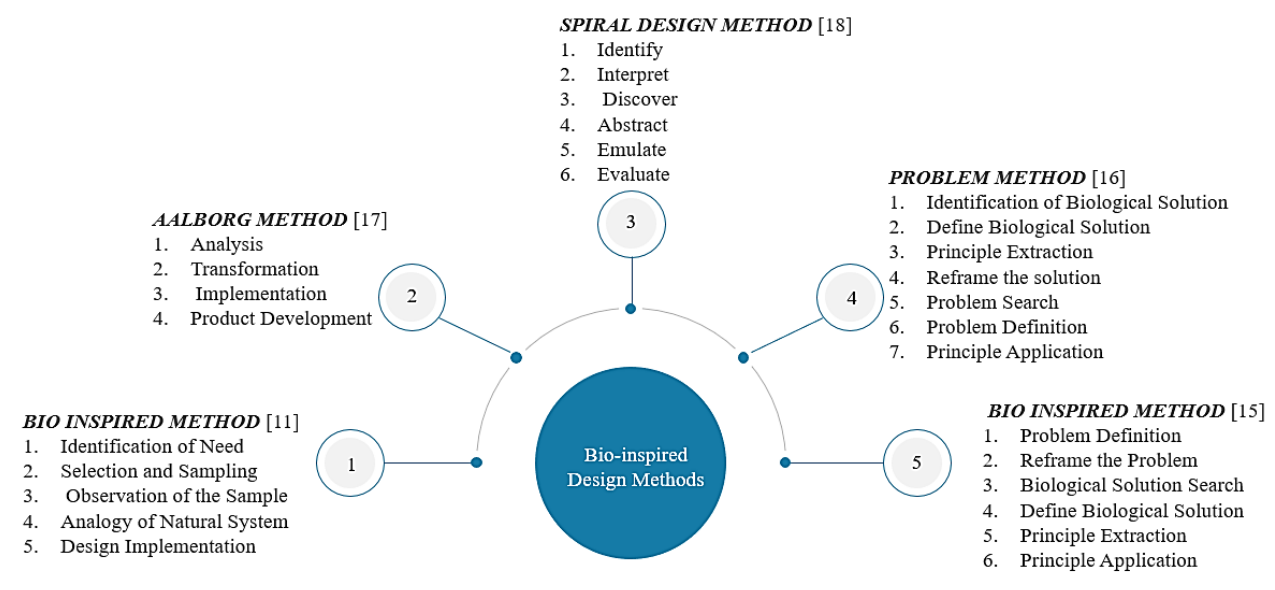
Figure 1. The bio-inspired design methods[19]